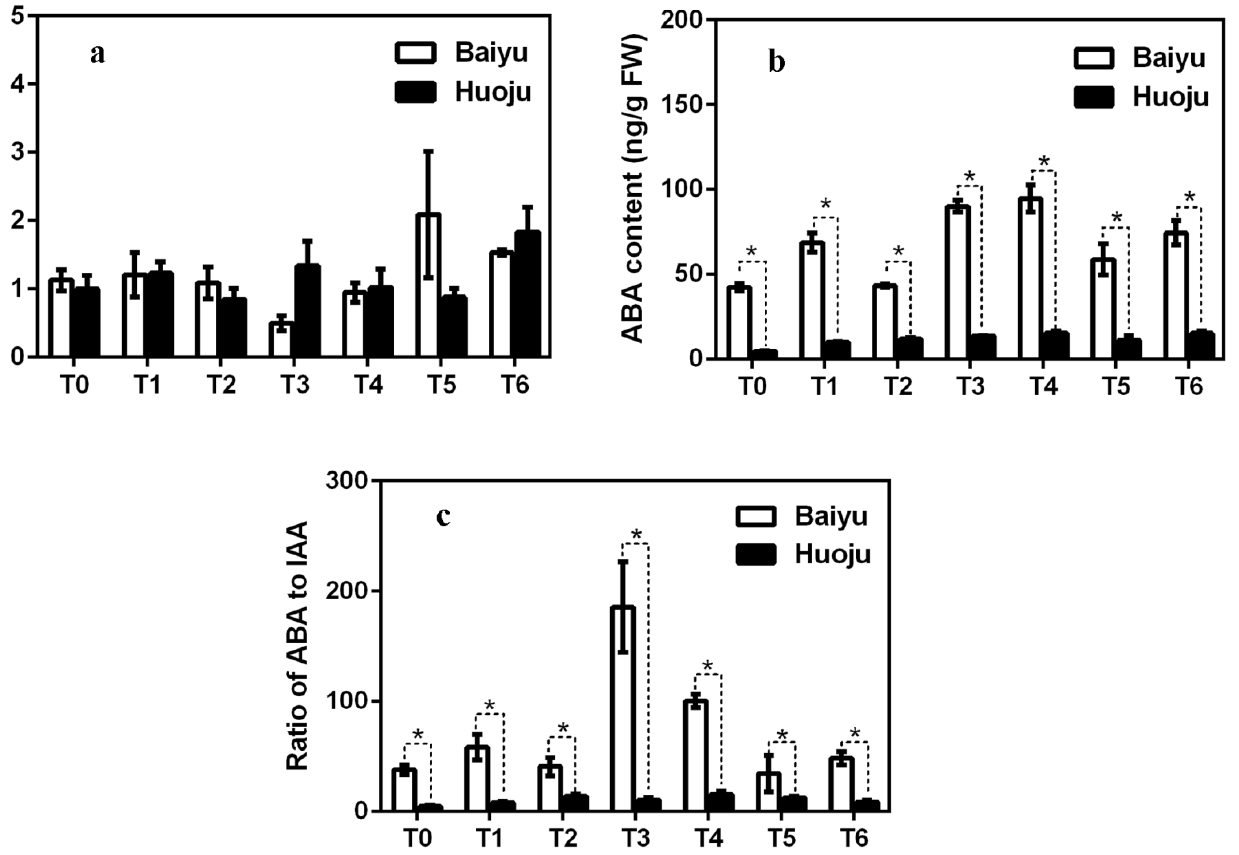
Figure 1. Dynamics of endogenous phytohormone IAA ( a ), ABA ( b ) and ratio of ABA to IAA ( c ) during loquat flower bud differentiation. T0–T6 in horizontal axis indicates sampling dates, i.e., 7–13, 7–19, 7–27, 8–03, 8–10, 8–17, and 8–24, respectively. * indicates significance at p ≤ 0.05. Bars indicate standard error.